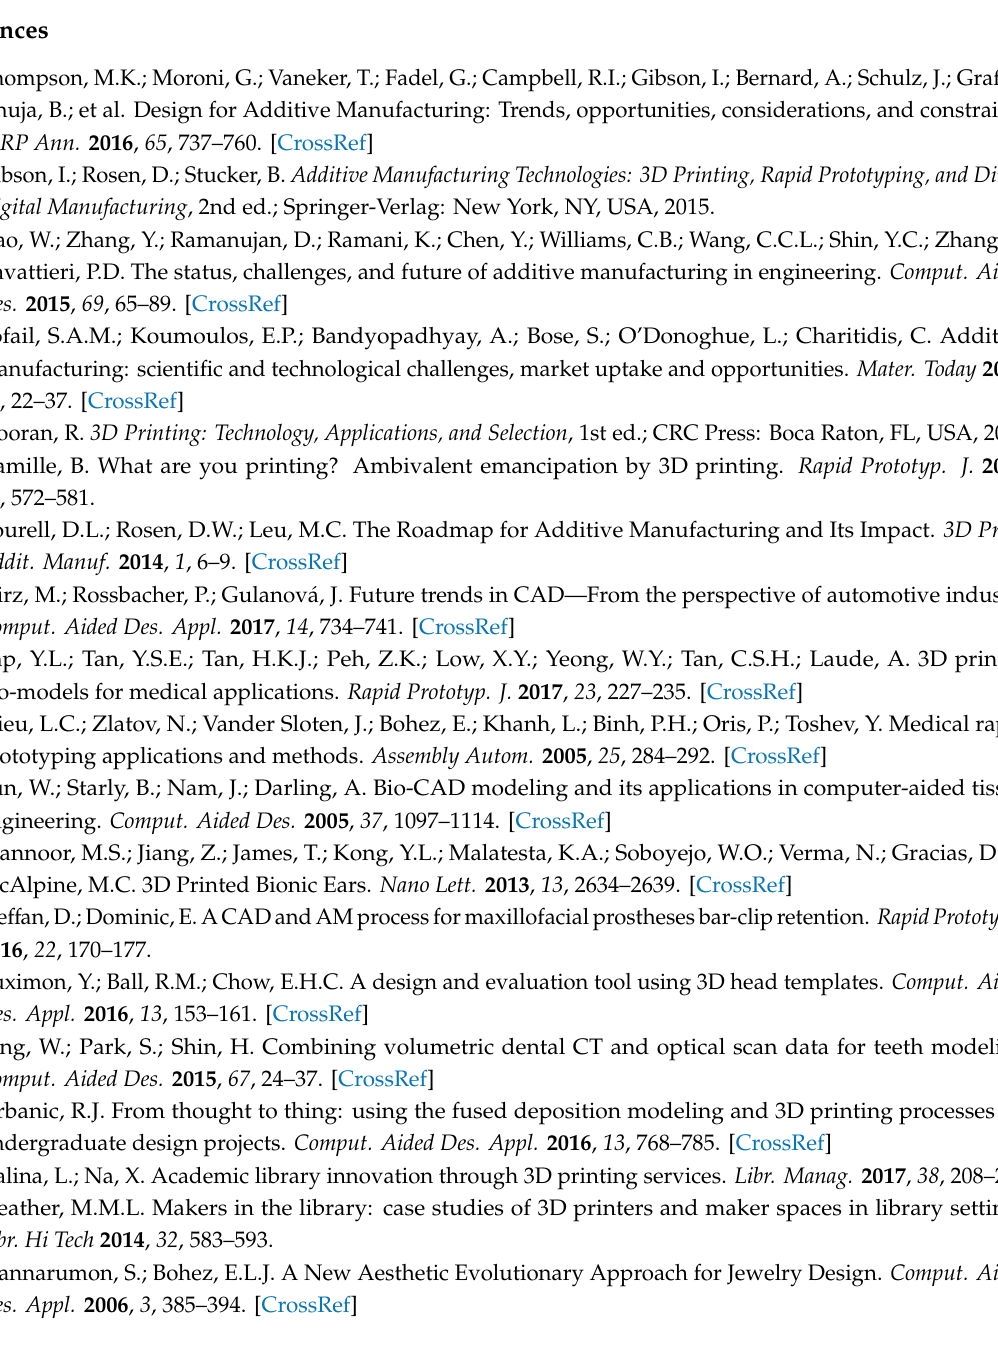
Figure B.1. Determining aesthetic value. ( a ) Parameters for determining the aesthetic value; ( b ) calculating aesthetic value using LCH.